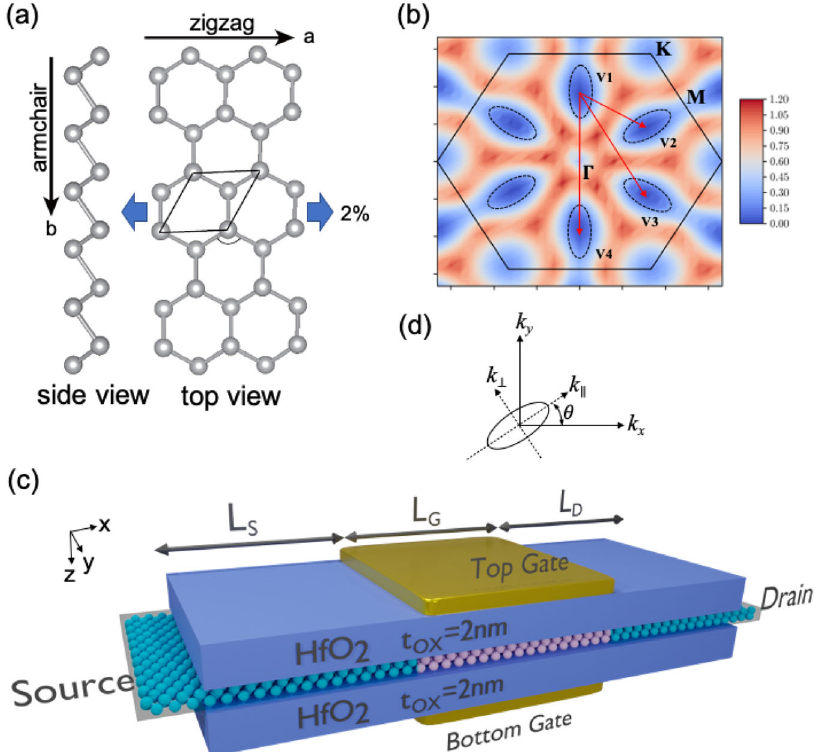
Fig. 1 Atomic, band structure, and device schematic. a Top and side views of the single-layer antimonene and arsenene atomic structure. The unit cell and the direction of the uniaxial strain is also represented. b Energy contour plots of the lowest conduction band (CB) in single- layer antimonene. Six-fold degenerate CB valleys are indicated. Three types of intervalley scattering channels are represented by red arrows. c Schematic view of the double-gate fi eld-effect transistor investigated in this work. The gate length L G varies between 4 and 9 nm. The source and drain extensions are doped with a donor concentration N D = 3.23 × 10 13 cm − 2 . The doping region is marked by blue color and stops exactly at the channel-source and channel-drain interfaces. Two t OX = 2 nm thick dielectric layers (HfO 2 ) sandwich the 2D material channel and separate it from the gate electrodes. Transport occurs along the x -axis, z is vertical con fi nement direction, and the device is assumed to be periodic along y . d local k -space reference frame ( k ∥ , k ⊥ ) of a CB valley and the global one ( k x , k y ), where k x and k y are the wavevector components along the transport and the transverse (periodic) direction,